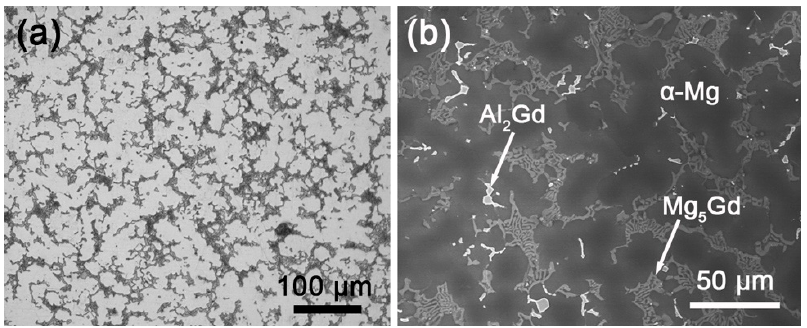
Figure 2. ( a ) OM and ( b ) SEM images of the as ‐ cast Mg–Al–Gd